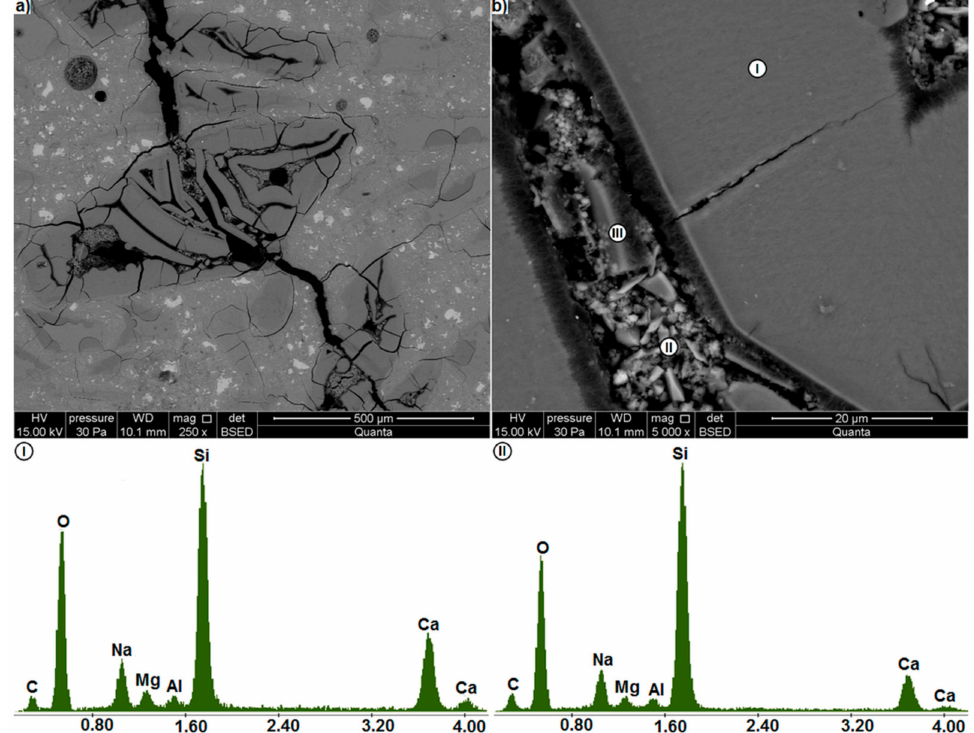
Figure 9. ( a ) extensively cracked region in the microstructure of the mortar containing waste glass ( b ) region of porous gel (BSE); EDS analysis at points I and II, ( c ) cracks in the gel.